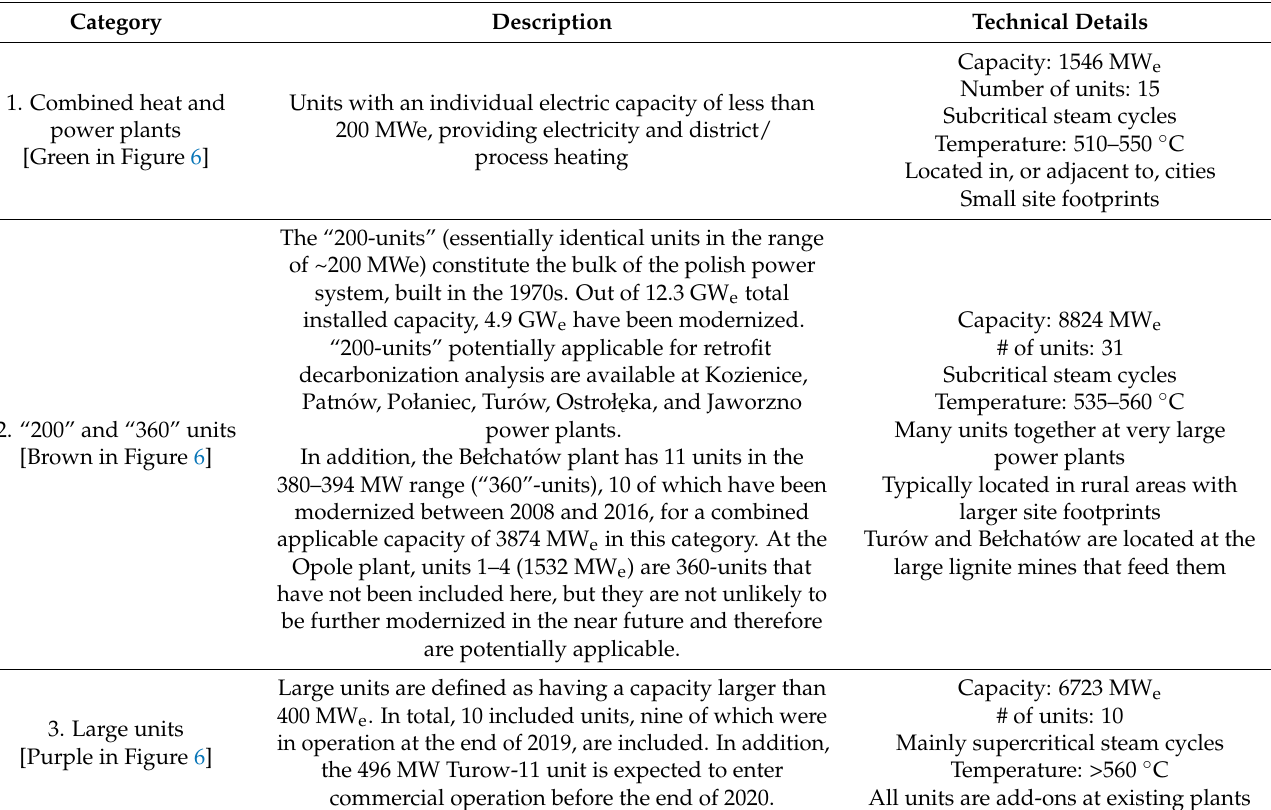
Table 3. Categorization of Polish Coal Power